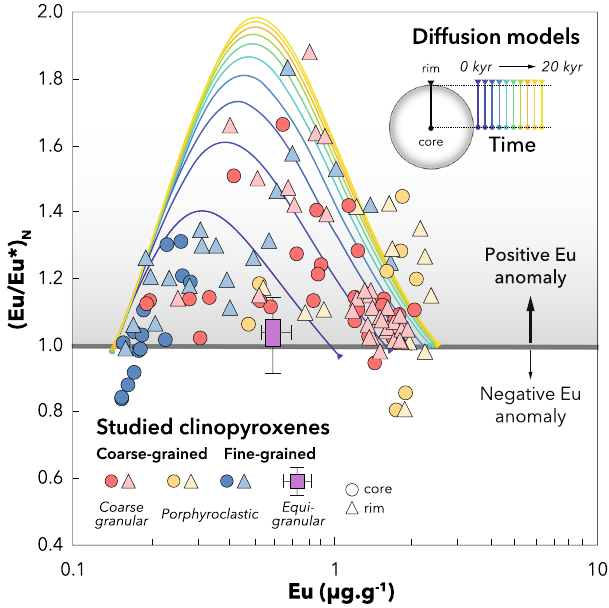
Fig. 2 | Transient evolution of the Eu anomalies in clinopyroxene. Data points arecolour-codedbasedonthetexturalclassi fi cationusedinFig.4andcomparedto the core-to-rim pro fi le simulated within a single clinopyroxene crystal after dif- ferent times (0 – 20kyr) by the percolation-diffusion model (see Methods). For the equigranular population, the mean value and external standard deviation are